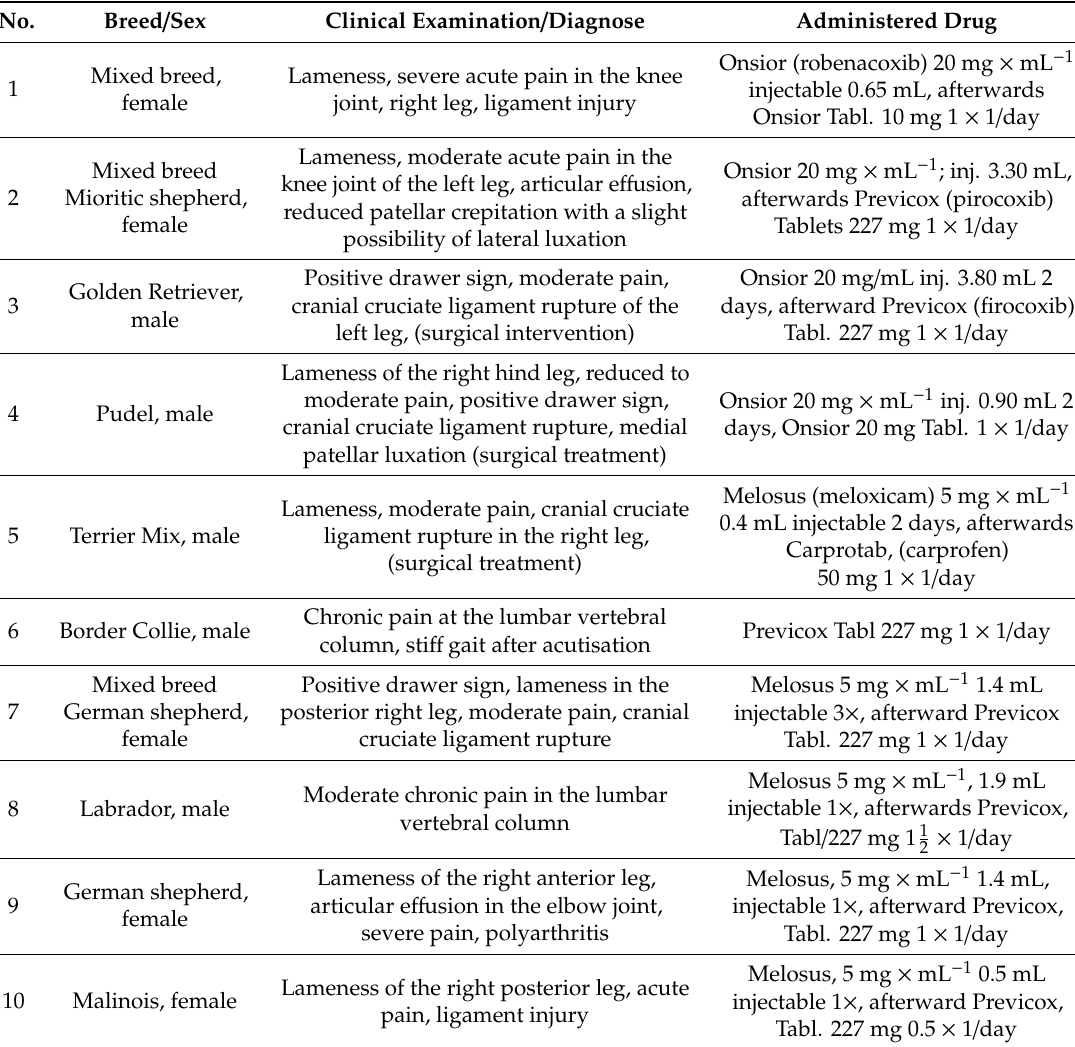
Table 2. Nonsteroidal Anti-Inflammatory Drugs (NSAID) administration protocol.